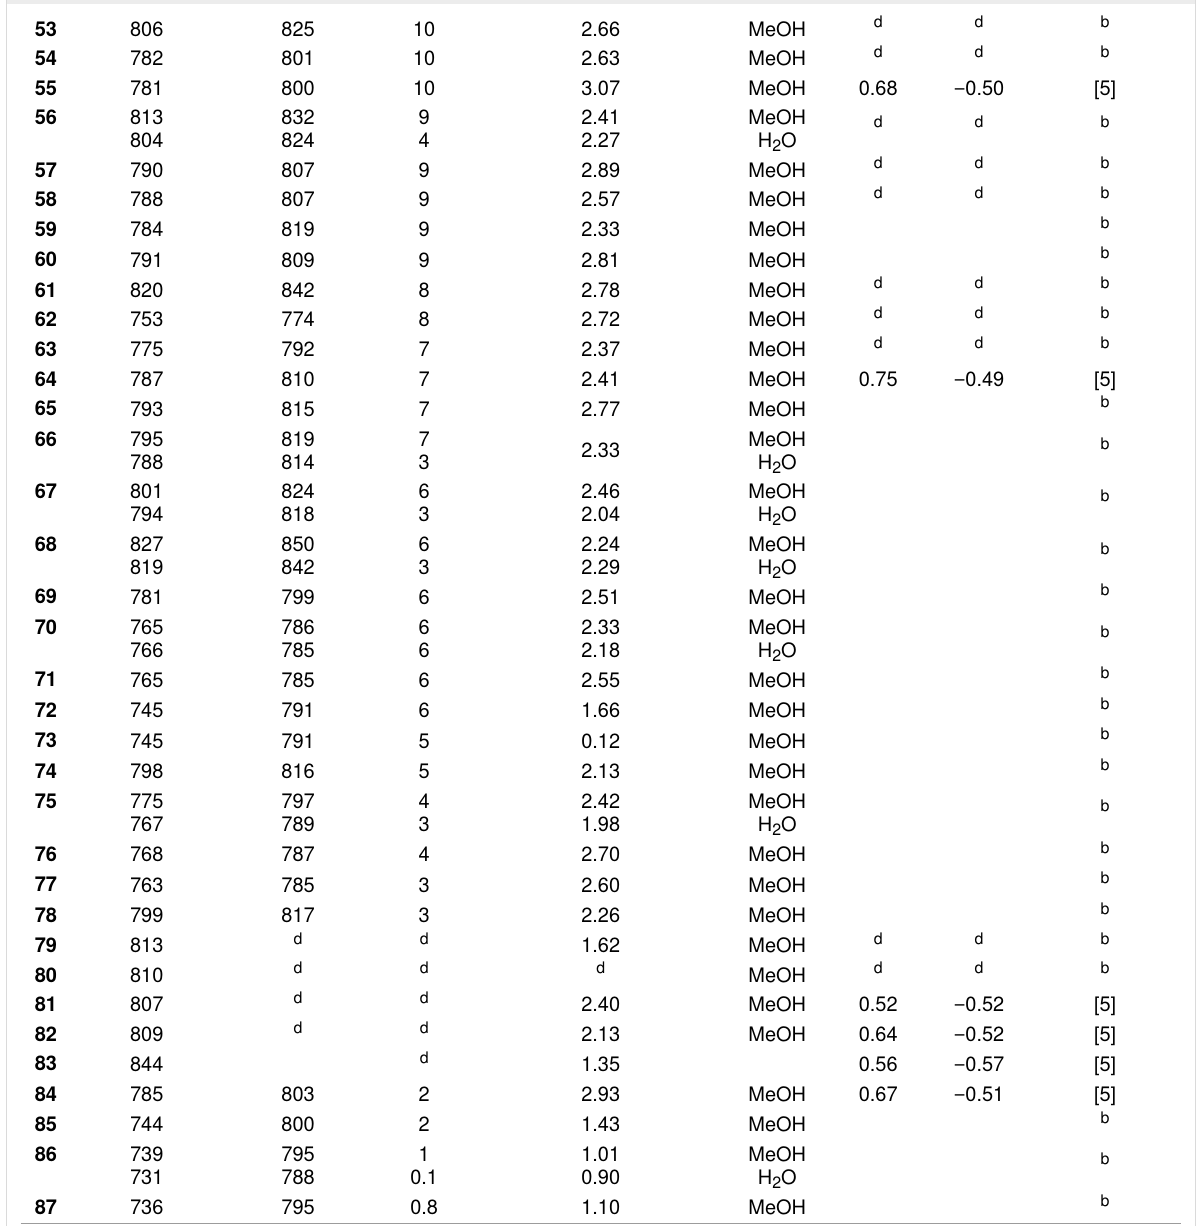
Table 2: Summary of photophysical (absorption maximum λ maxabs , fluorescence maximum λ maxflu , extinction coefficient ε , fluorescence quantum yield Φ f ) and electrochemical data (oxidation potential E ox , and reduction potential E red ). Data of absorbers a relate to the structural patterns I – V . Sup- porting Information File 1 gives information of the electrochemical measurements (data were taken in CH 3 CN), and the determination of photophysi- cal data. The latter complements previously published data [5,6] helping to receive a more completed pattern about these NIR absorbers.